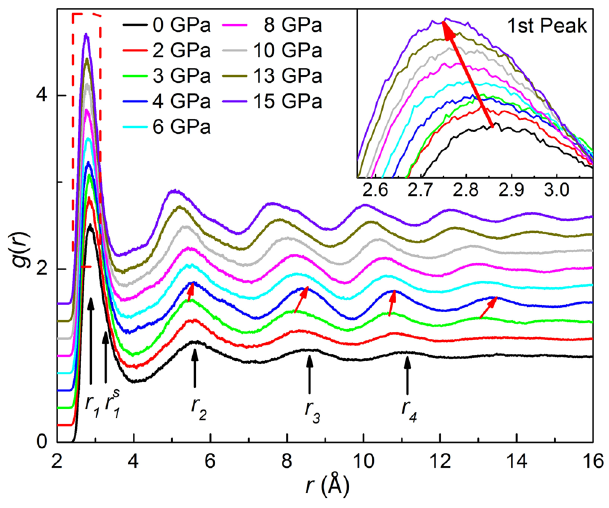
Figure 5. The pressure dependence of pair correlation function g ( r ) as calculated with AIMD method. The inset shows the magnification of the first peak in g ( r ). The red arrows denote sudden jumps in peak positions of the 2 nd to 4 th shells between 3 and 4